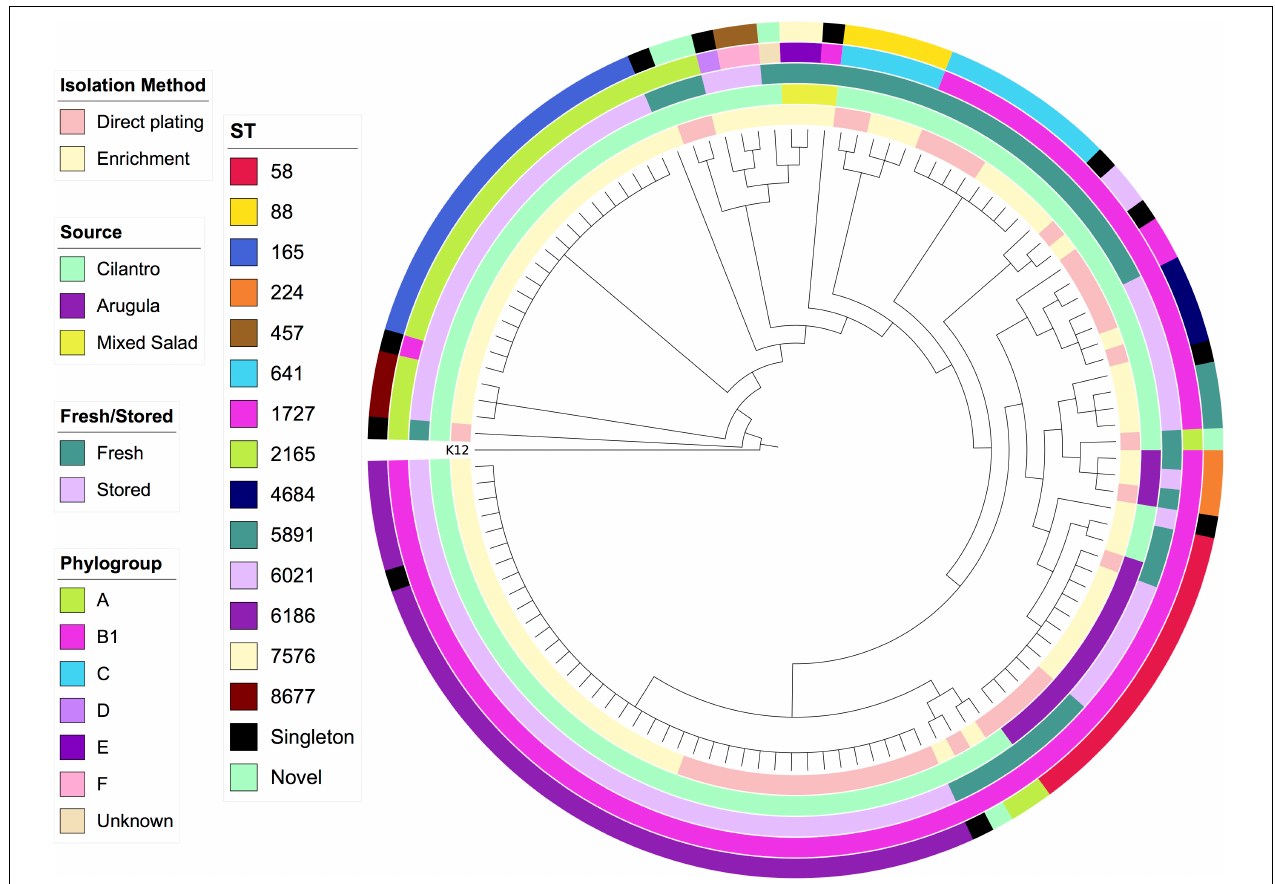
FIGURE 1 | Maximum-likelihood SNP-based cladogram of 120 E. coli from produce based on reference genome E. coli K12-MG1655. Metadata rings labeled from innermost to outermost; isolation method, source, fresh/stored, phylogroup, Achtman ST.